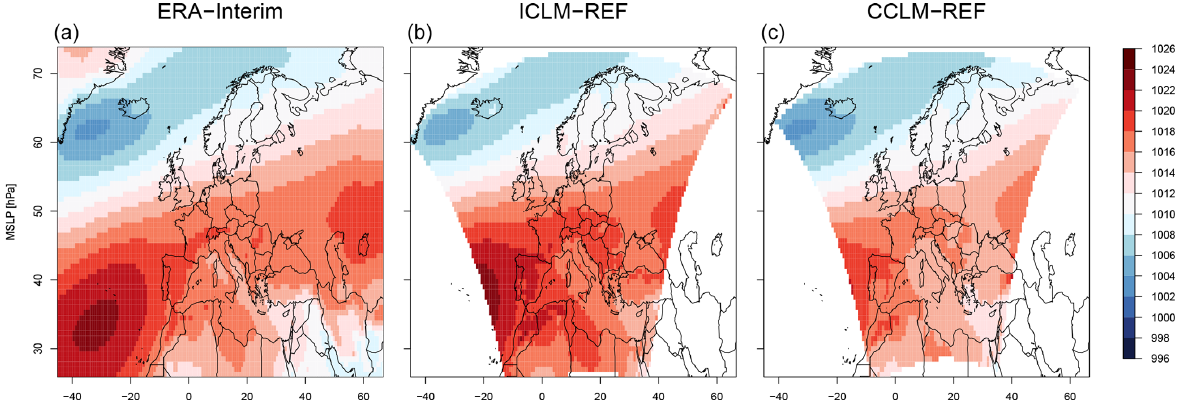
Figure 12. Annual mean sea level pressure (MSLP, in hPa) from ERA-Interim (a) , ICLM-REF (b) and CCLM-REF data (c) . Data were averaged over the period